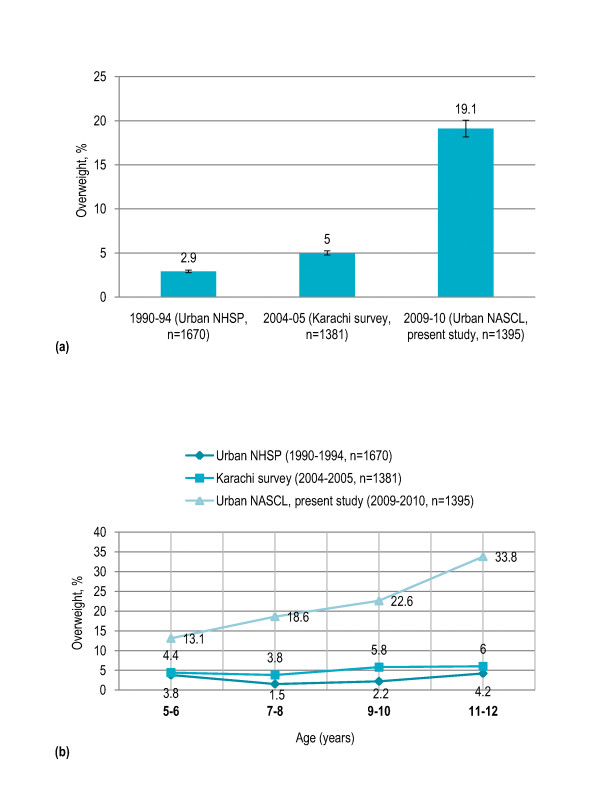
Trend in prevalence of overweight among urban primary school children in Pakistan; (a) shows over-all trend, and (b) shows age-specific trend. Note: US CDC 2000 child growth reference (defining overweight as >85th percentile BMI-for-age) was used in the previous studies, and results from urban sample in the present study are presented with respect to the same reference for purpose of trend analysis.